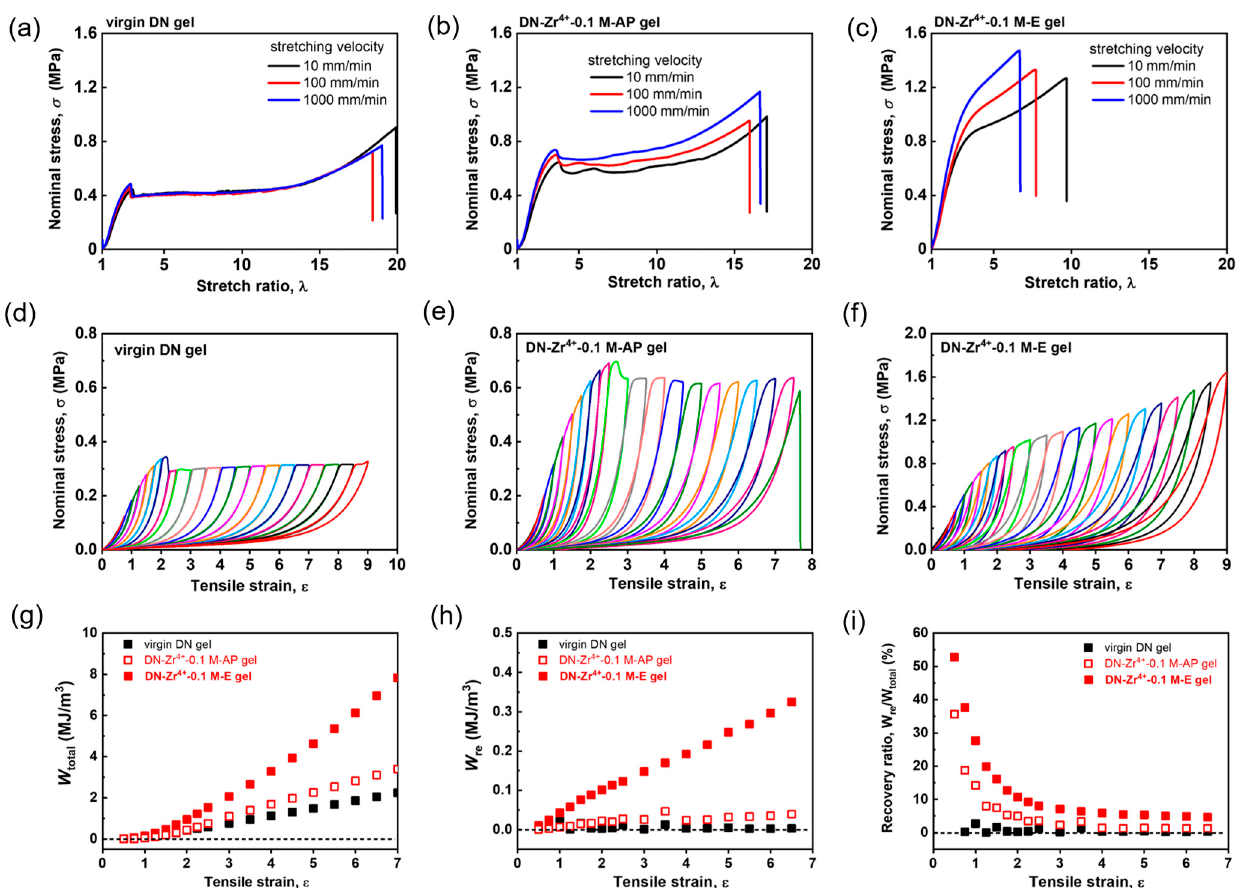
Figure 4. Tensile behaviors and cyclic tensile behaviors for various DN hydrogels with Zr 4+ as metal ions for the metal coordination complex. ( a ) Rate-independent elastic tensile behaviors of the virgin DN hydrogels under different deformation rates ranging from 10 to 1000 mm/min. ( b ) Rate-dependent viscoelastic tensile behaviors of the DN − Zr 4+ − 0.1 M − AP hydrogels under different deformation rates ranging from 10 to 1000 mm/min. ( c ) Rate-dependent viscoelastic tensile behaviors of the DN − Zr 4+ − 0.1 M − E hydrogels under different deformation rates ranging from 10 to 1000 mm/min. ( d – f ) Sequential loading–unloading cycles for the virgin DN gels ( d ), DN − Zr 4+ − 0.1 M − AP hydrogels ( e ), and DN − Zr 4+ − 0.1 M − E hydrogels ( f ) at a deformation rate of 100 mm/min. The virgin DN hydrogels show completely irreversible hysteresis, while the rate-dependent viscoelastic DN − Zr 4+ − 0.1 M − AP hydrogels and DN − Zr 4+ − 0.1 M − E hydrogels show partially reversible hysteresis. The total mechanical hysteresis W total ( g ), the reversible mechanical hysteresis W re ( h ), and the recovery ratio W re /W total ( i ) as functions of tensile strain for various DN